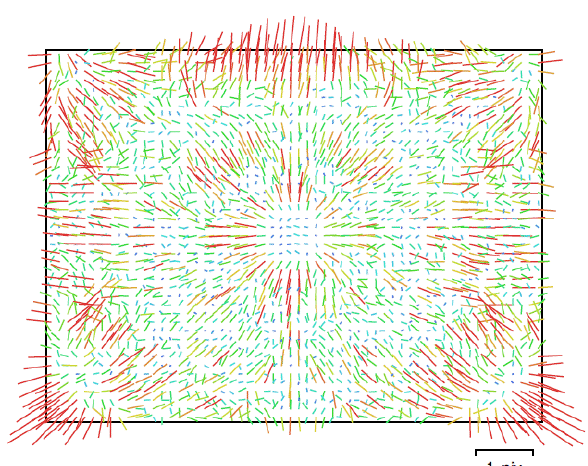
Figure 15. Image residuals for DJI Matrice with Zenmuse X5S (Agisoft